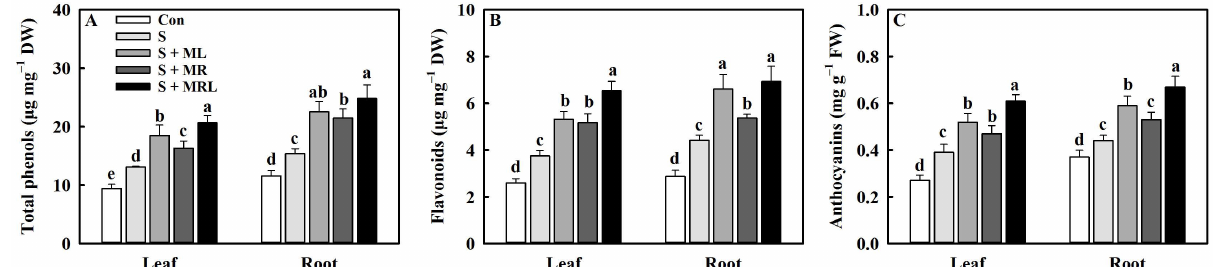
Figure 7. Effect of different methods of melatonin application on the contents of phenolic compounds of sugar beet seedlings under salt stress. ( A ) Total phenol content, ( B ) flavonoid content, and ( C ) anthocyanin content in the leaves and roots. Con, control treatment; S, salt stress treatment; S + MR, salt stress treatment + root application of melatonin; S + ML, salt stress treatment + foliar application of melatonin; S + MRL, salt stress treatment + combined root and foliar applications of melatonin. Data show the means ± standard errors ( n = 4). Different letters indicate significant differences between treatments according to Duncan’s multiple range test ( p < 0.05).